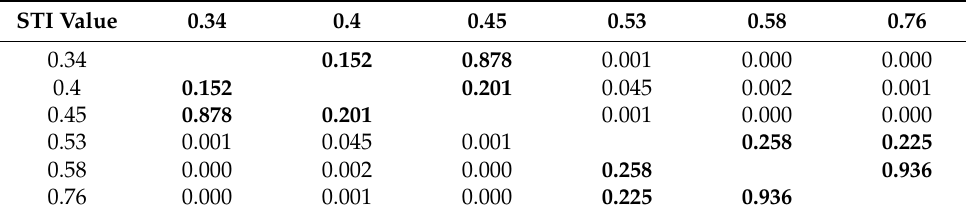
Table 6. Matrix of p -values obtained after carrying out Dunn’s post hoc test for the maximum intelligible RoS value. Statistically insignificant values are marked with a gray